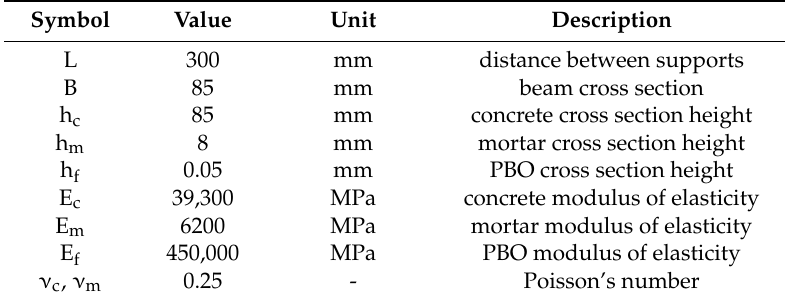
Table 1 : Nominal data used for computing strain values in the concrete beam and in the FRCM reinforcement.